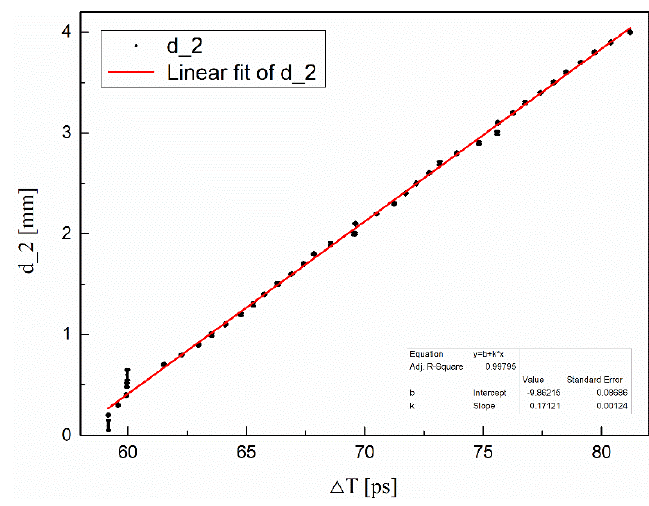
Figure 8. The relation curve between d_2 and Δ T and the linear fit of d _ 2.